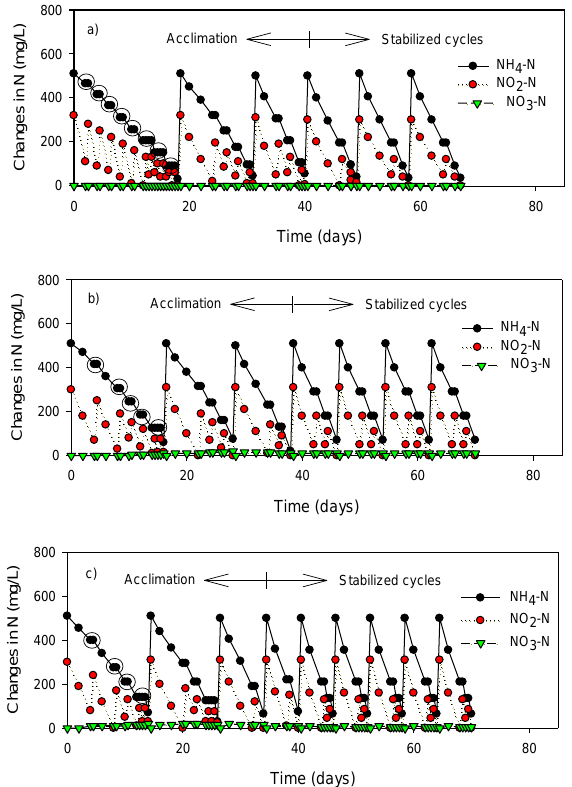
Figure 2. Changes in ammonium and nitrite concentrations depending on the electrostatic field strength